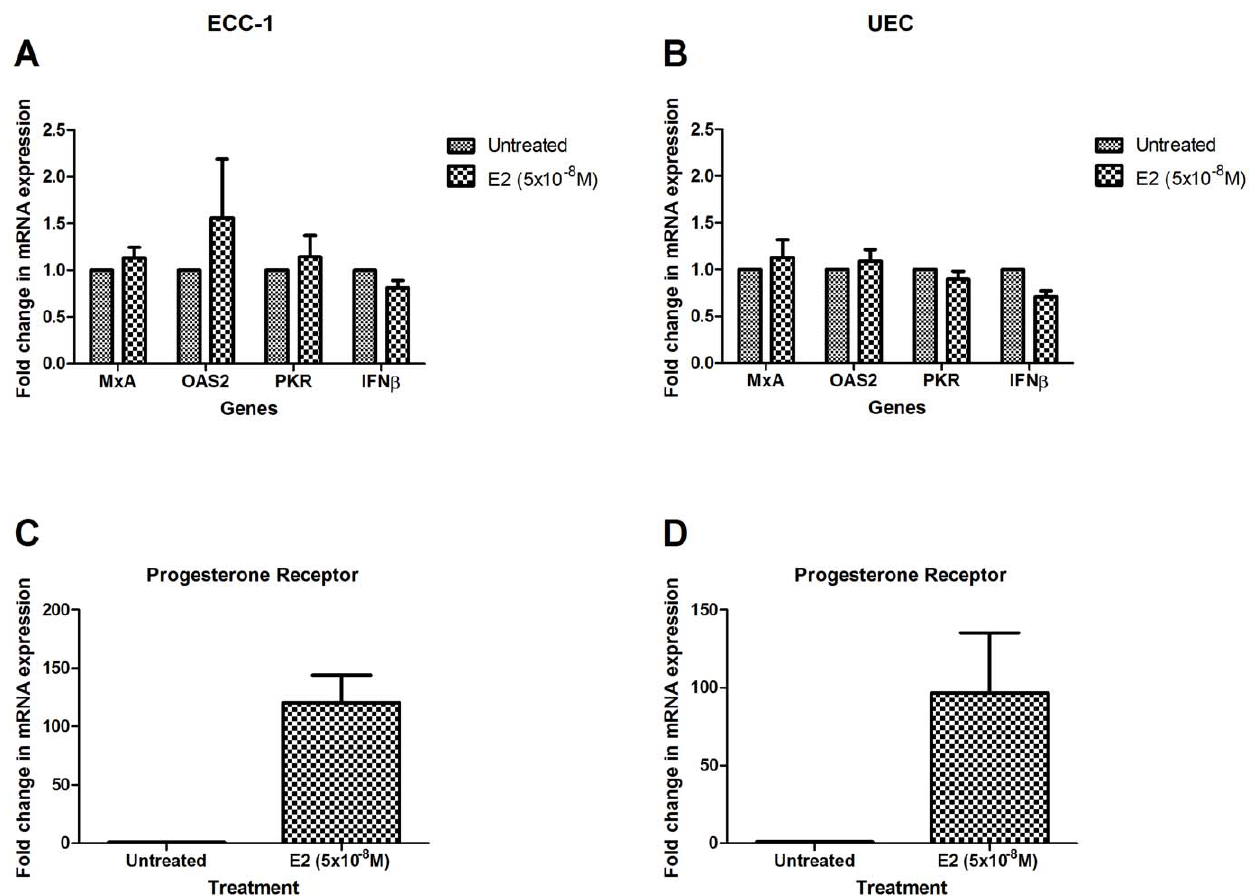
Figure 5. Estradiol has no effect on IFN b and ISG transcript levels. ECC-1 ( n=3 ) (a & c) and primary human UEC ( n=5 ) (b & d) were stimulated apically and basolaterally by estradiol (5 6 10 2 8 M) for 24 hours. mRNA was recovered and analyzed for changes in gene expression. mRNA is expressed as a fold change over untreated samples (assigned a value of 1). Results are shown as the mean + / 2 SEM.